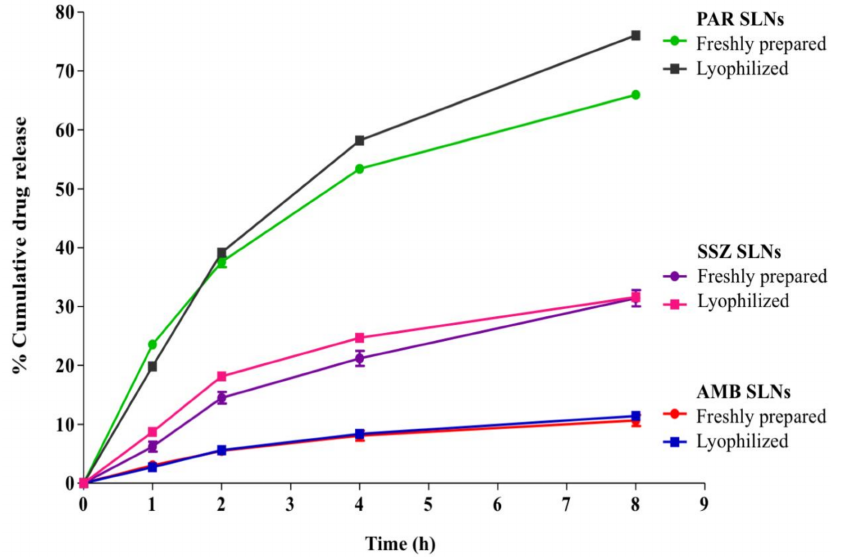
Figure 6. Cumulative drug release from freshly prepared and lyophilized AMB-SLNs, PAR-SLNs, and SSZ-SLNs in PBS (phosphate-buffered saline; pH